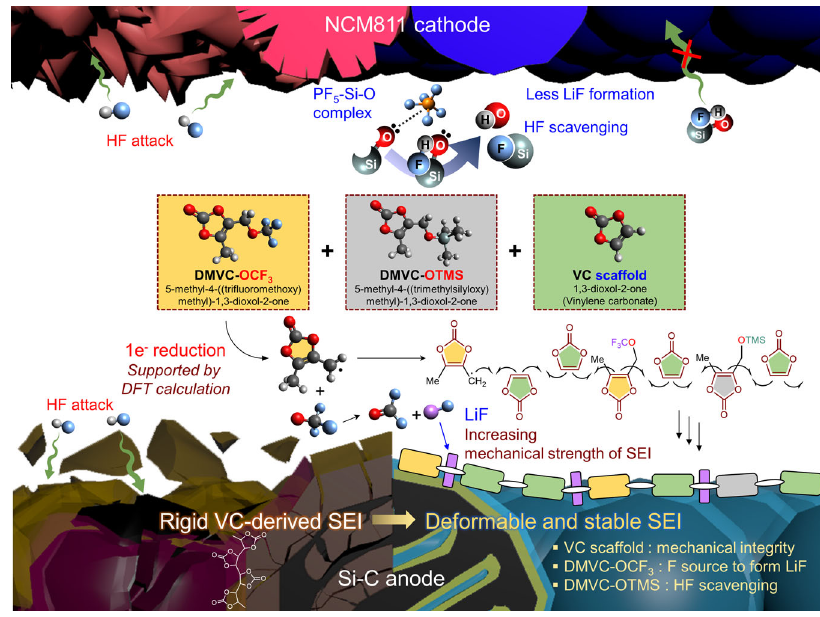
Fig. 2 Unique features of DMVC-OCF 3 , DMVC-OTMS, and VC for building stable interfacial layers. Incorporation of DMVC-OCF 3 and DMVC-OTMS in the VC scaffold leads to the creation of a fl exible and robust SEI on the Si – C anode. DMVC-OTMS scavenges HF and deactivates PF 5 , resulting in compositional and structural stability of the interfacial layers on the electrodes. The Me ( − CH 3 ) moiety bonded to the VC scaffold provides ion channels, providing space for Li-ion transport in the